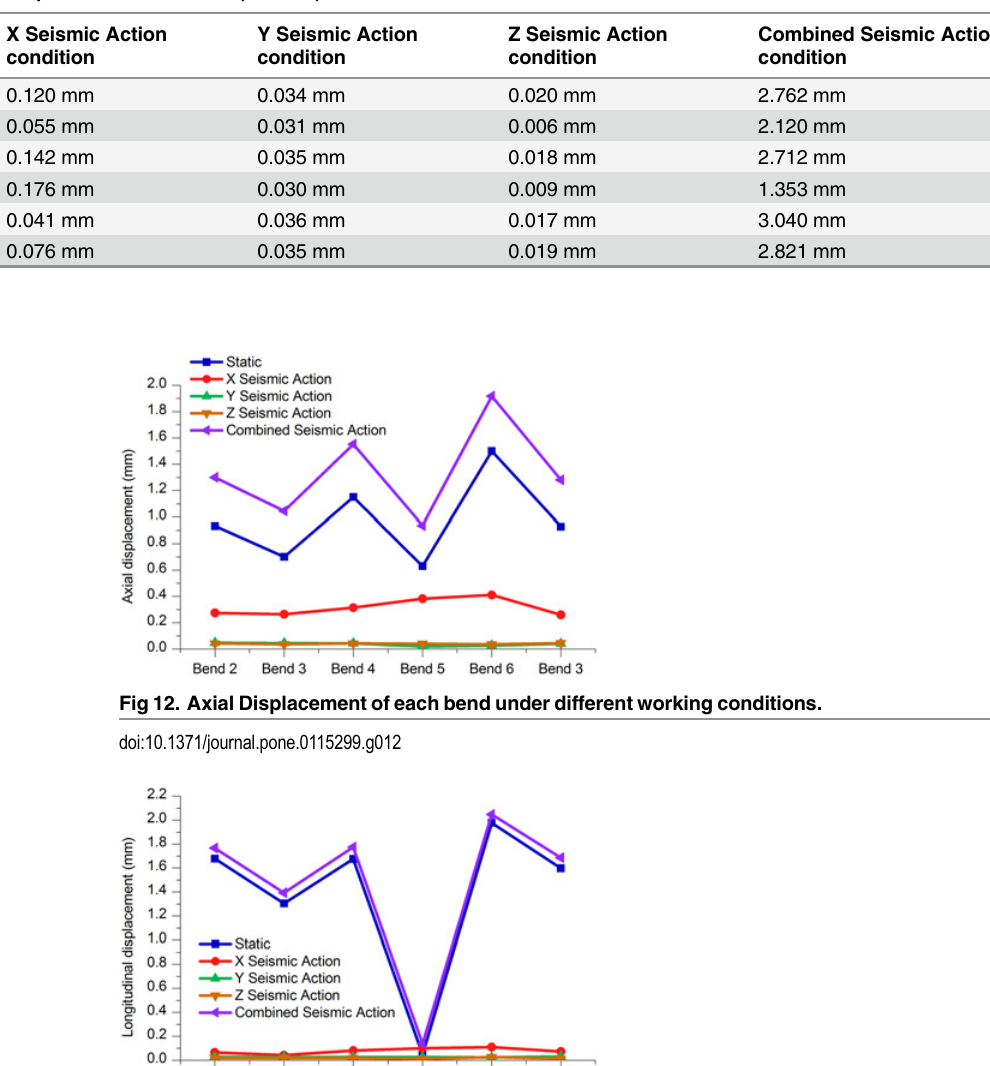
Table 13. Comparison of lateral displacements of bends (25° – 45°) under different conditions.